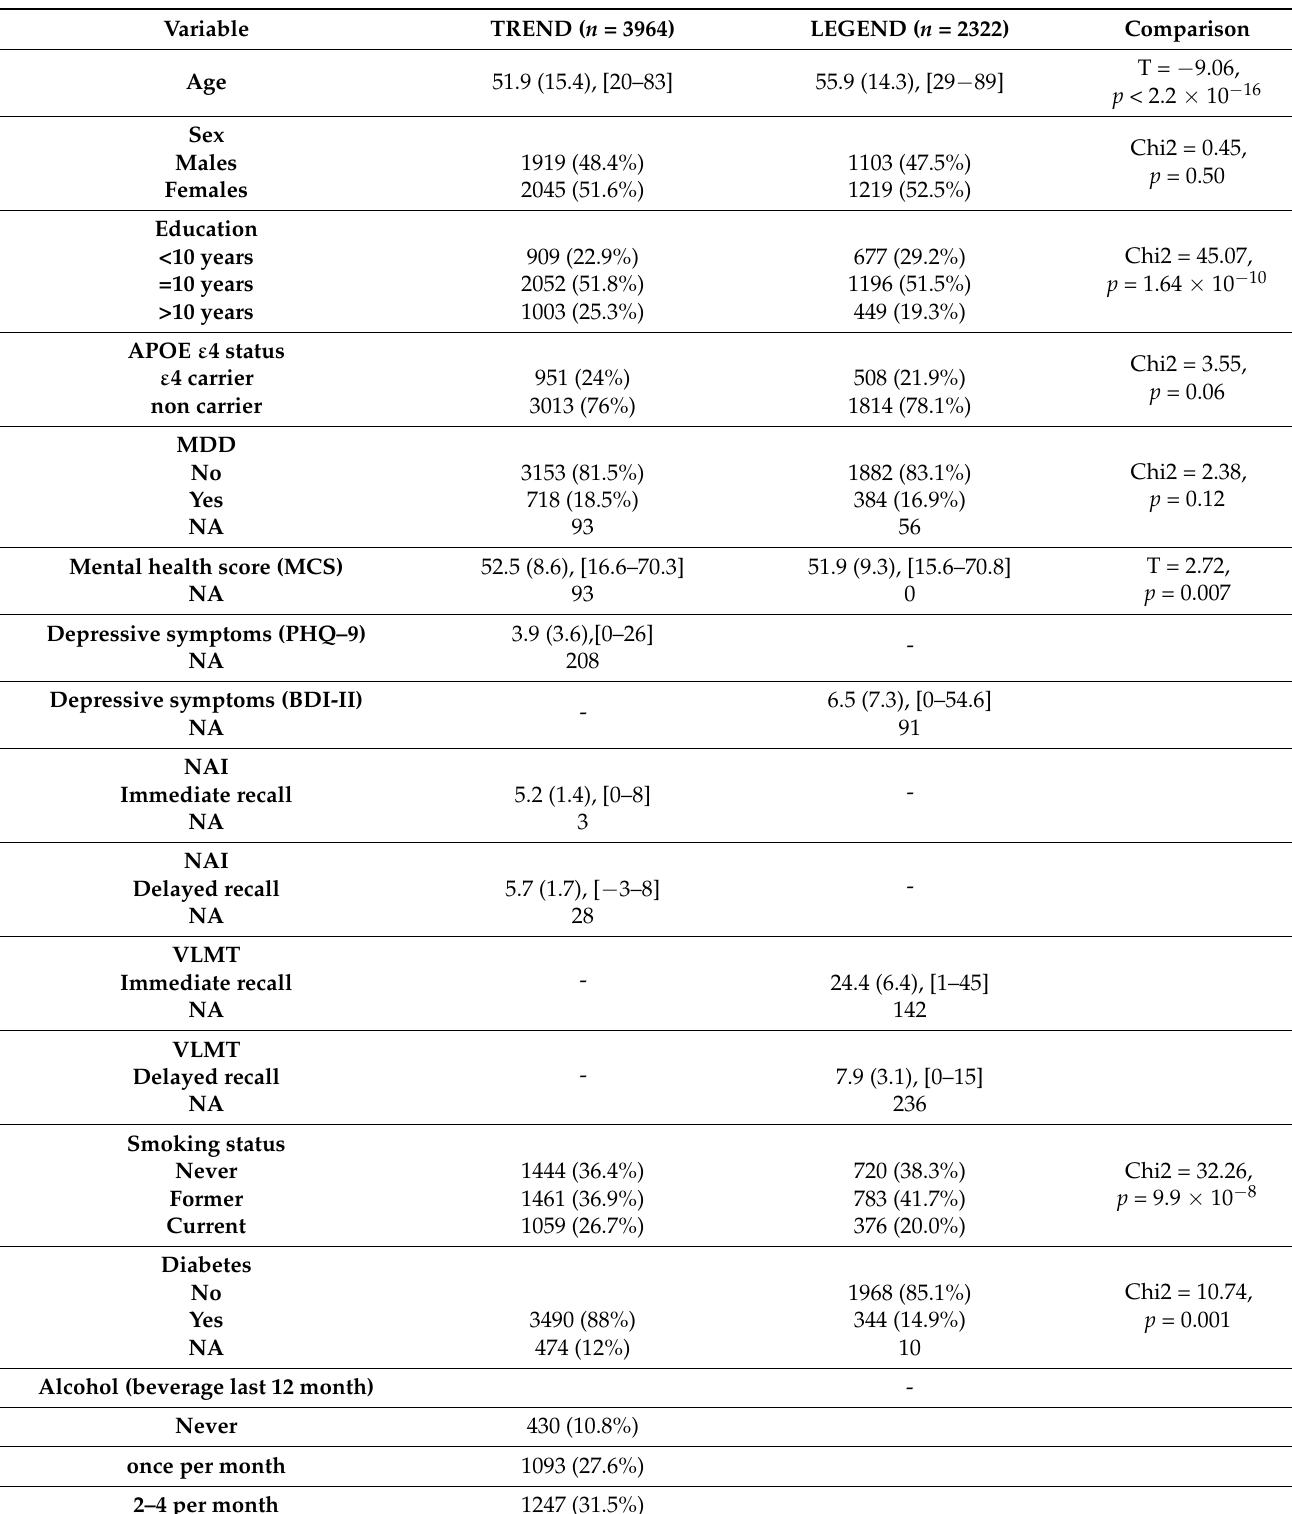
Table 1. Sample characteristics of TREND and LEGEND (consensus sample; for TREND, complete cases for adjustment set 2 and APOE ε 4 status; for LEGEND, complete cases for adjustment set 1 and APOE ε 4 status). For metric variables, mean, standard deviation, and range are given; for categorical variables, counts and percentages are